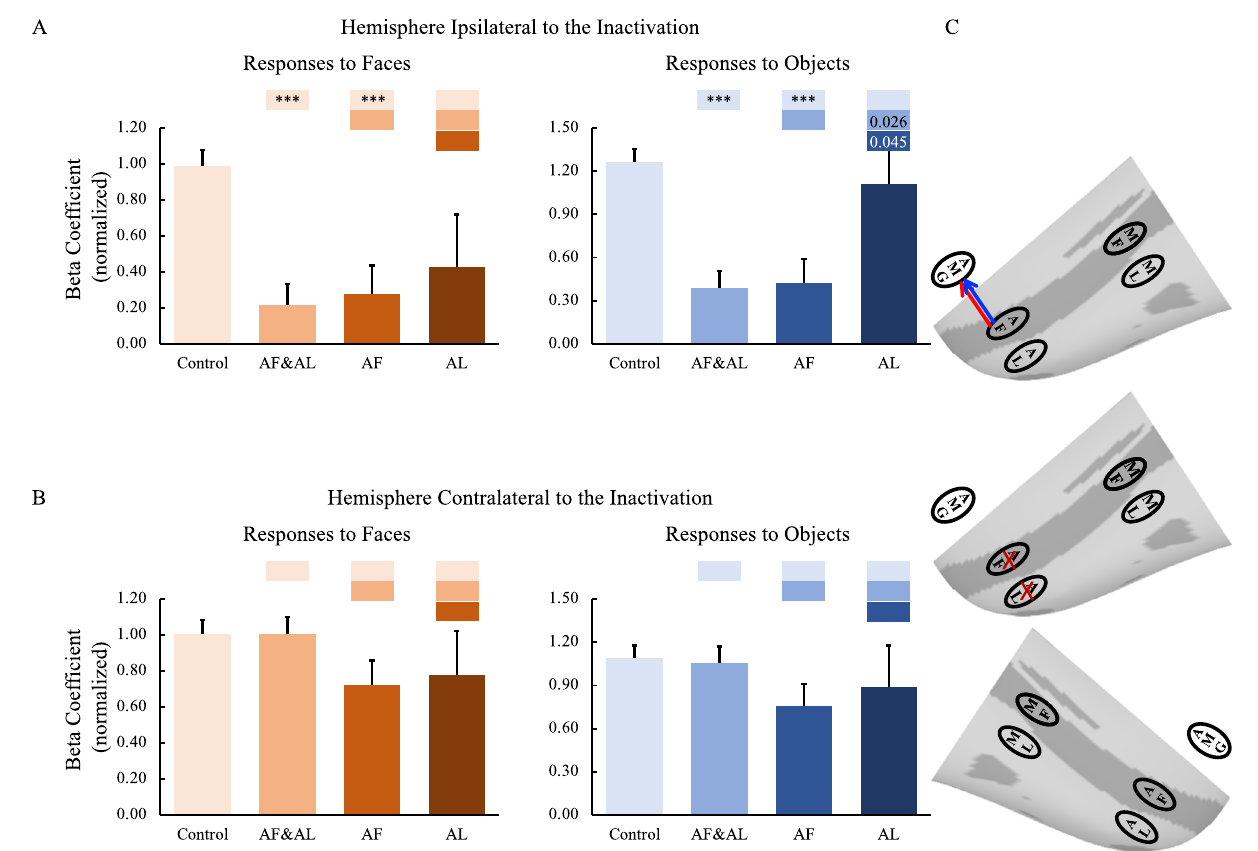
Fig.7|Effectsofanteriorfacepatchinactivationonresponsesintheamygdala. A , B Effects of anterior face patchinactivation onresponses tofacesand objectsin the amygdala in the hemispheres ipsilateral and contralateral to the inactivation sitesacrossbothmonkeys.Boxplotsdisplaymeanvalues±SEM.AF&AL:combined AF and AL inactivation; AF: AF alone inactivation; AL: AL alone inactivation. Gen- eralized Linear Mixed Models were performed for each ROI (AF, MF, and ML: n =486; AL: n =336) with Treatment and Hemisphereas fi xed factors, and Monkey (C and D), L-R hemisphere (Left and Right), Session, and Run as random factors. Post hoc testing was done with correction for multiple testing using the